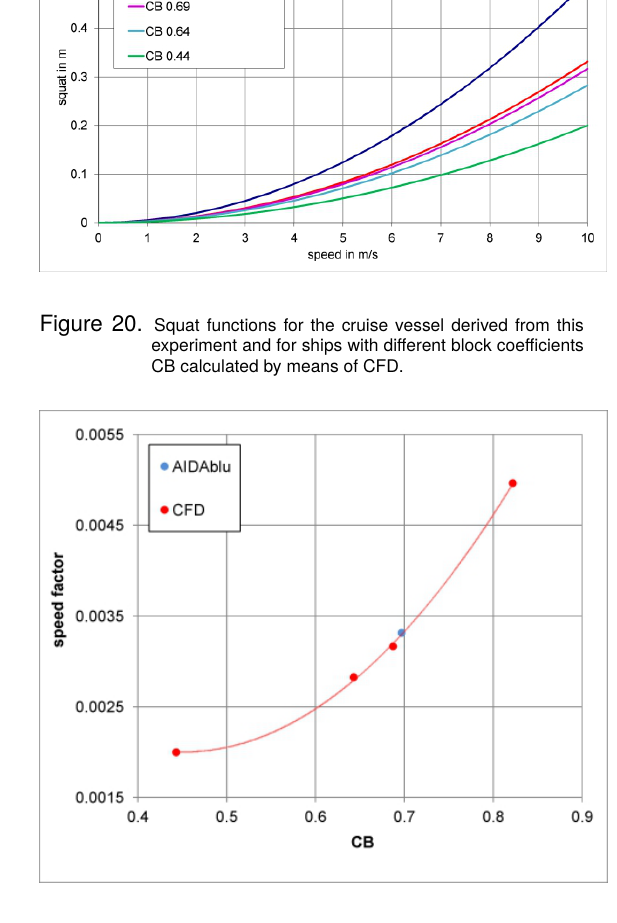
Figure 21. Speed factors of squat functions from CFD calculations and for the cruise vessel AIDAblu from this investigation.